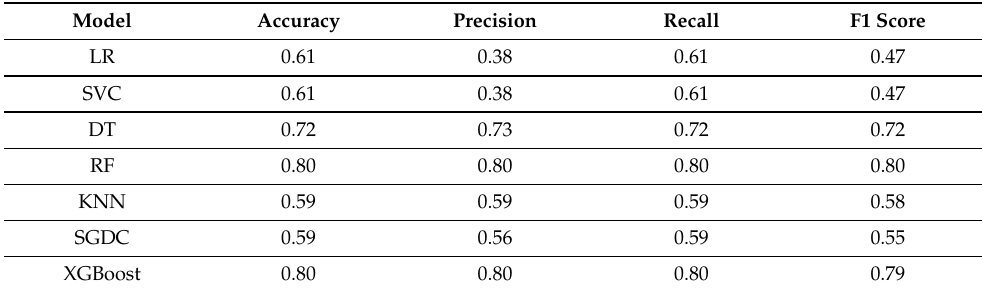
Table 5. Results of machine learning models using KNN